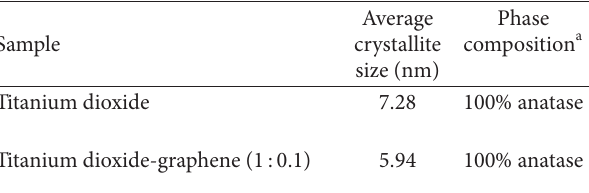
F 6: Fluorescence emission spectra of (a) titanium dioxide